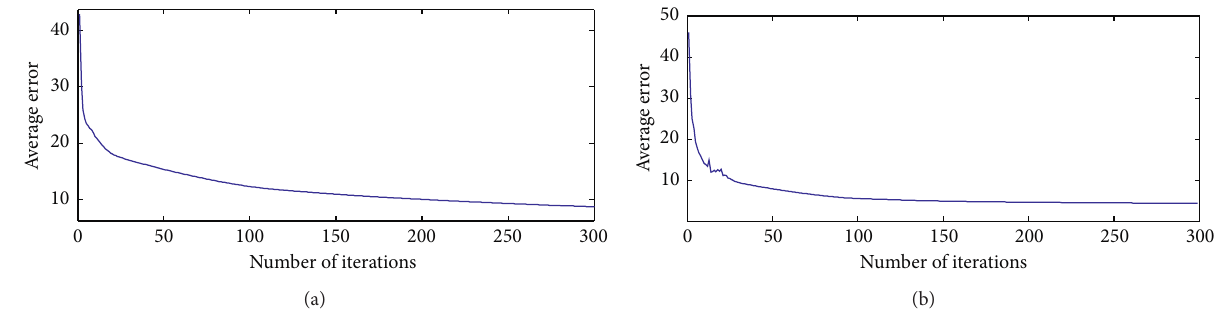
Figure 7: Performance curves of different forecast models. (a) WNN. (b) WNN-GA. Table 3: Forecast error of using different methods, unit: person- times.